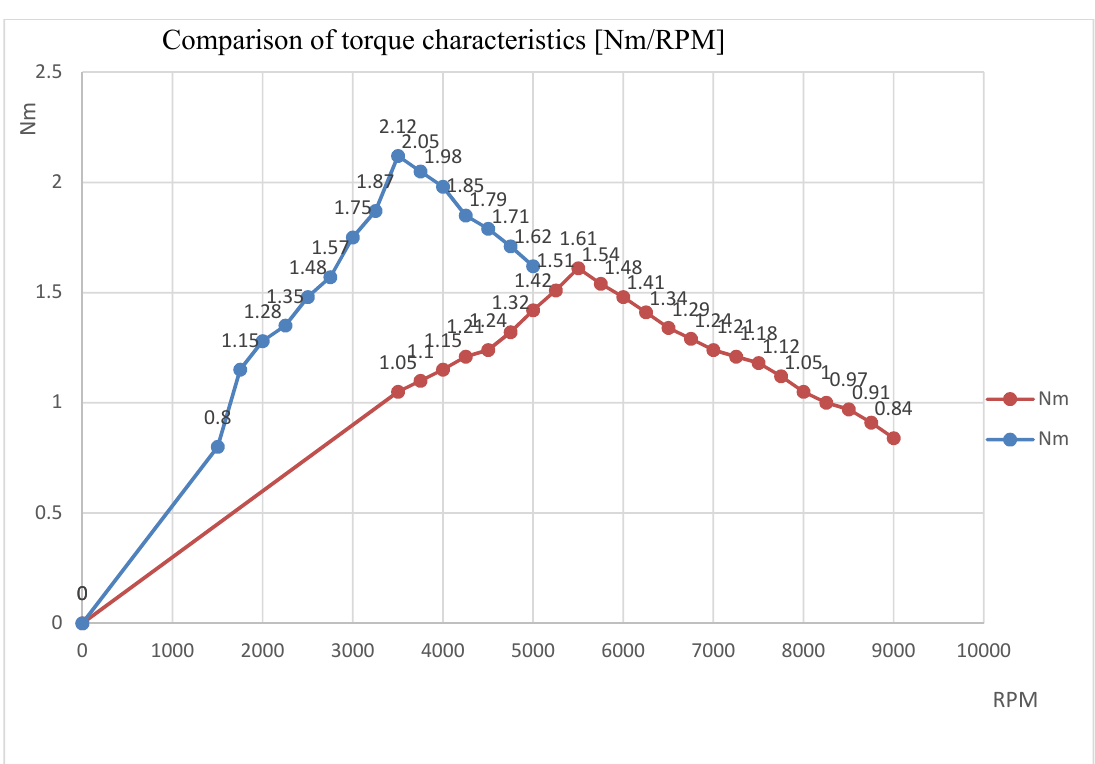
Figure 25. Comparison of torque characteristics with serial piston and piston no. 3 (optimum).